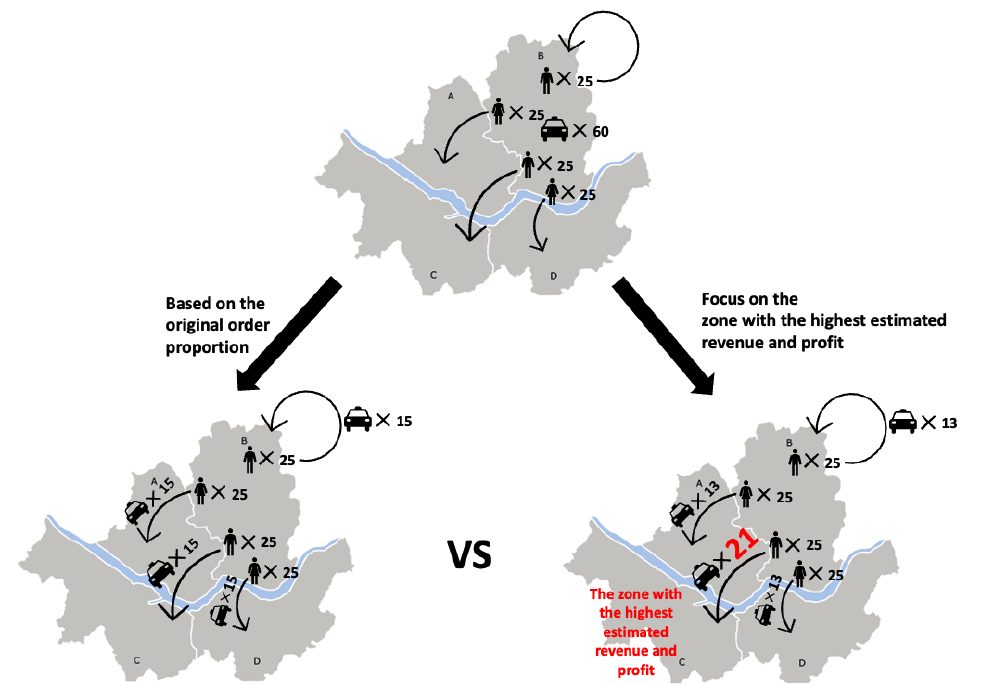
Figure 2. Consider an example where 100 passenger orders exceed the supply of 60 taxis in zone B. We can assign more taxis to the zone with the highest expected revenue and profit-generation opportunities (for example, zone C). Such an approach would generate a better result than the naïve approach of dividing the fleets in proportion to the current demand for different zones without predicting the situation at the drop-off